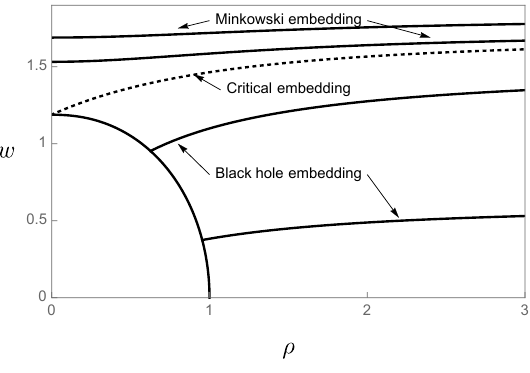
Figure 1 . Pro(cid:12)les of the di(cid:11)erent types of embeddings for E = (cid:10) =